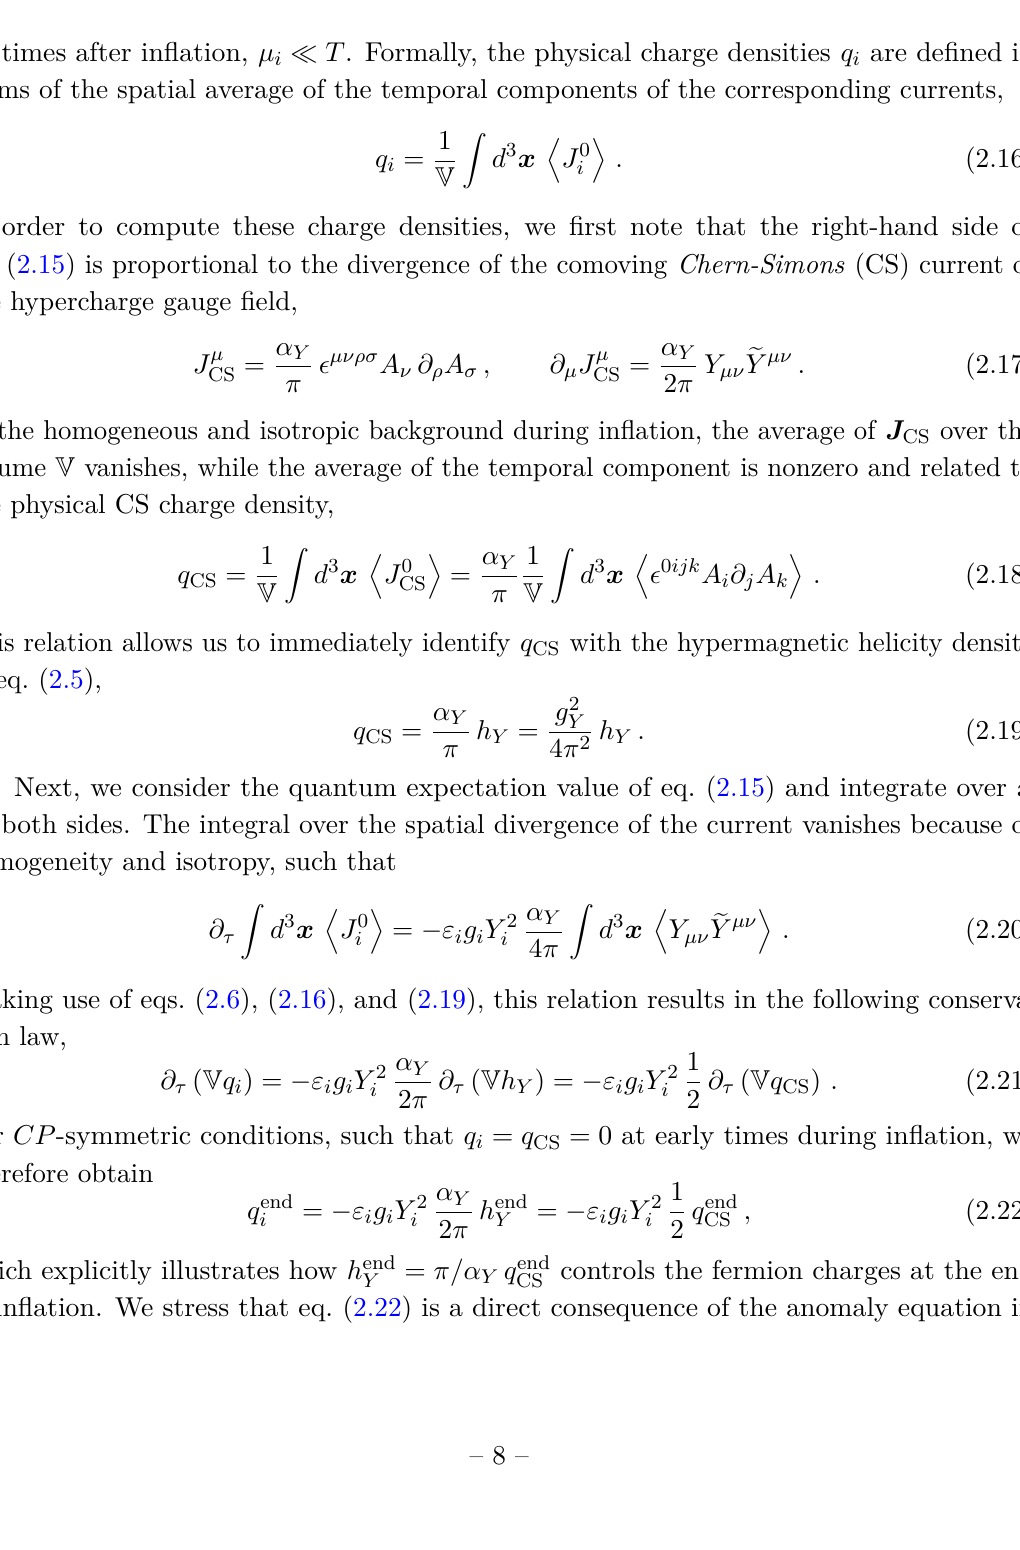
Table 1 . Numerical factors appearing in eq. (2.15): the index i labels the 15 SM fermion represen- tations; ε i distinguishes between left- and right-handed fermions; g i counts internal gauge degrees of freedom; and Y i stands for the SM